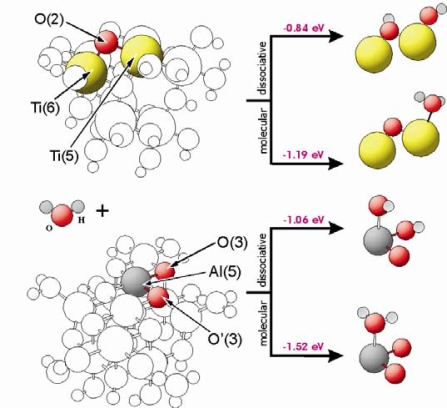
Geometric structure of water at TiO2 and Al2O3. Colour code: (oxygen: red, titanium–yellow, aluminium–dark gray, hydrogen–light gray).